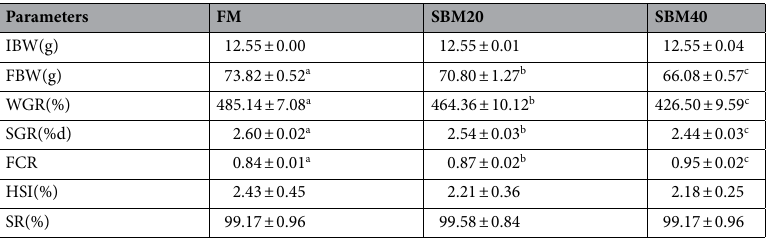
Table 1. Effect of different levels of soybean meal protein substitute for fish meal protein on the growth of pearl gentian grouper (n = 3). Results are presented as the mean ± SD. Values in a row with different superscripts represent significantly different at P < 0.05. IBW is the initial body weight, FBW is the final body weight, WGR is the weight gain rate, SGR is the special growth rate, FCR is the feed conversion rate, HSI is the hepatosomatic index and SR is the survival